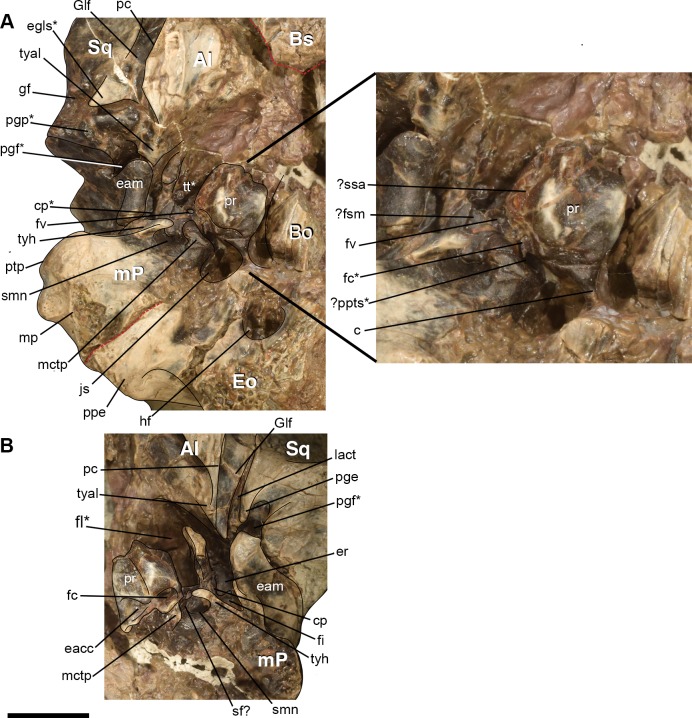
Auditory region of Periptychus carinidens (AMNH 3669).(A) The right auditory region of AMNH 3669 with a cut out to annotate finer anatomical details. Major anatomical boundaries are lined. (B) The left auditory region of AMNH 3669. Abbreviations: Al, alisphenoid; Bo, basioccipital, Bs, basisphenoid; c, commissure, cp, crista parotica; eam, external acoustic meatus; egls, entoglenoid process of the squamosal; Eo, exoccipital; er, epitympanic recess; fc, fenestra cochlearis; fi, fossa incudis; fl, foramen lacerum; fv, fenestra vestibuli; gf, glenoid fossa; Glf, Glaserian fissure; hf, hypoglossal foramen; lact, lateral articulation for the anterior crus of the ectotympanic; mctp, medial posterior tympanic process; m(P) mastoid bone of the petrosal; mp, mastoid process; pc, preotic crest; pge, postglenoid eminence; pgf, postglenoid foramen; pgp, postglenoid process; ppe, paroccipital process of the exoccipital; ppts, postpromontorial tympanic sinus, pr, promontorium; ptp, post-tympanic process of the squamosal; sf, sulcus facialis; smn, stylomastoid notch; Sq, squamosal; ssa, sulcus for the stapedial artery; tyal, tympanic process of the alisphenoid; tyh, tympanohyal; *, denotes damage; ?, uncertainty of label. Scale bar: 10mm.